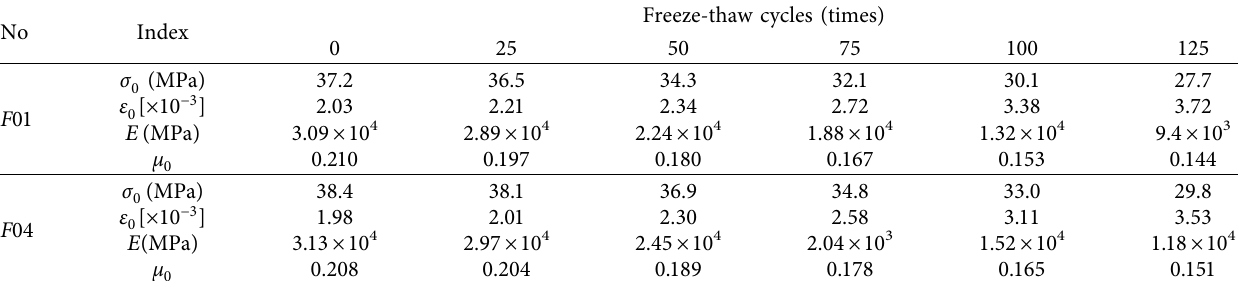
Figure 10: Relation between damage rate and freeze-thaw cycles. Table 5: Mechanical properties of OC and DSC with 50%